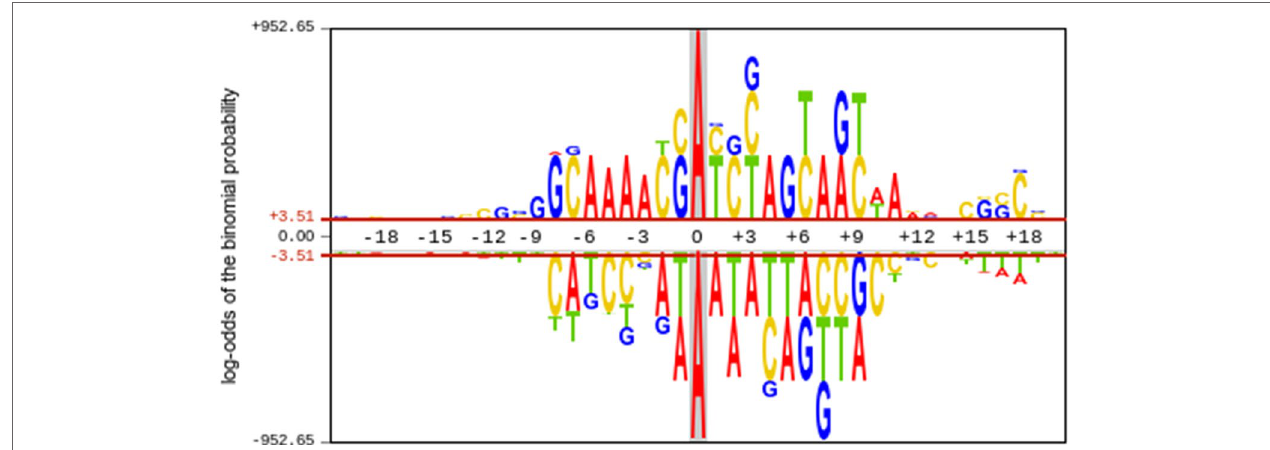
FIGURE 3 | Nucleotide distribution preferences around 6mA and non-6mA sites. The upper half of the x-axis indicates the nucleotide distribution in 6mA site containing sequence, whereas the lower half of the x-axis indicates the nucleotide distribution in non-6mA site containing